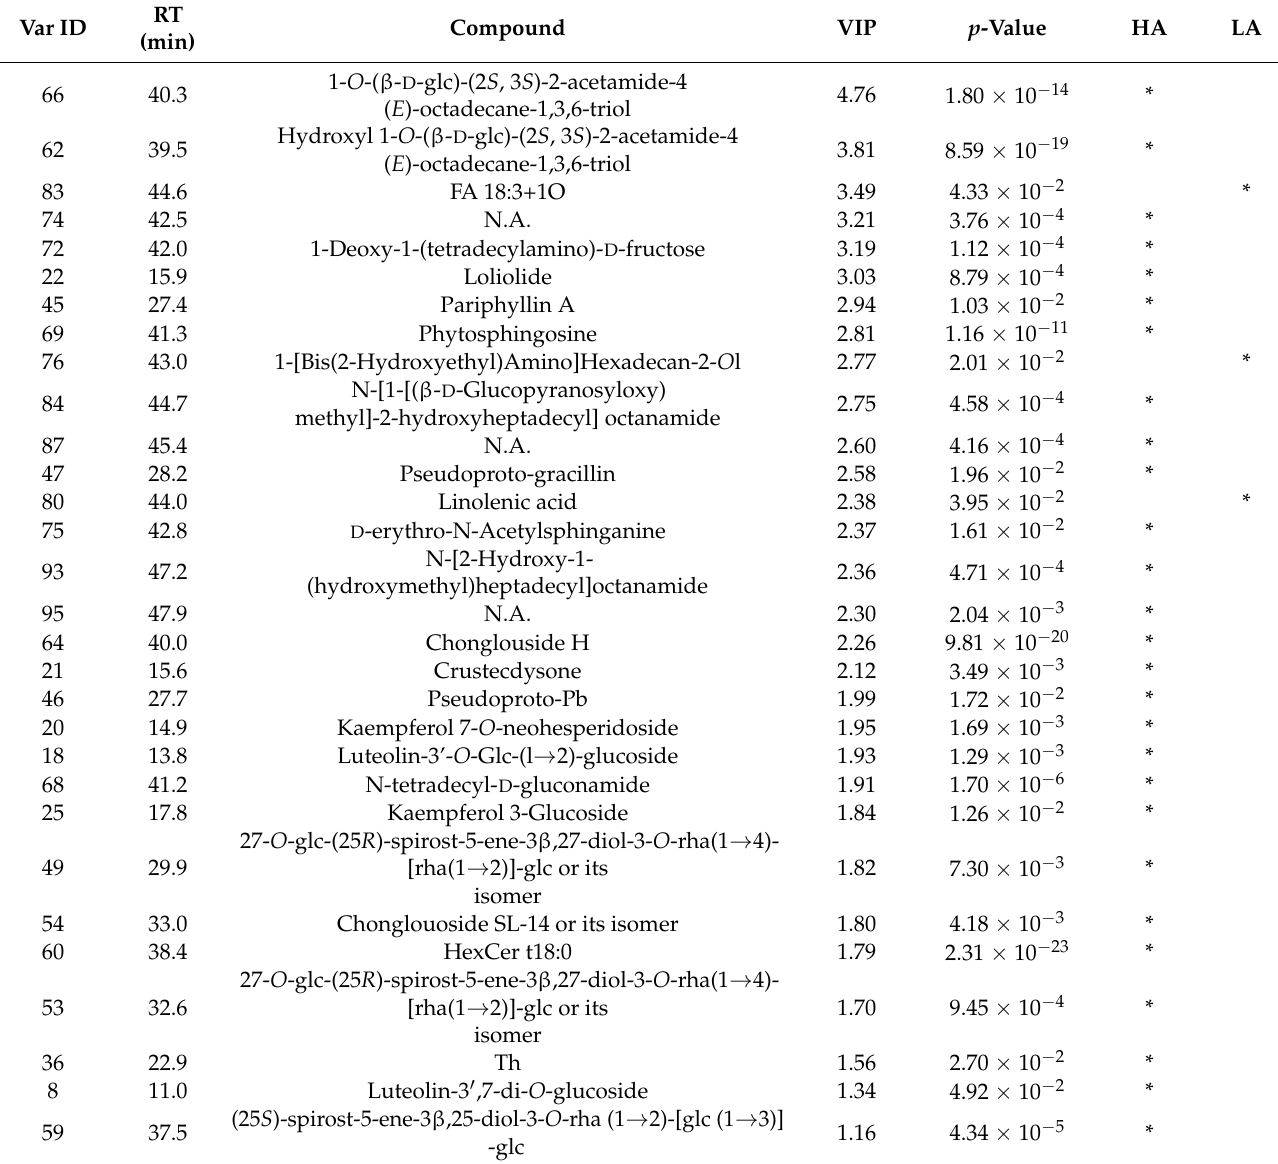
Table 3. The main variables identified based on VIP > 1 and p -value < 0.05 between HA and